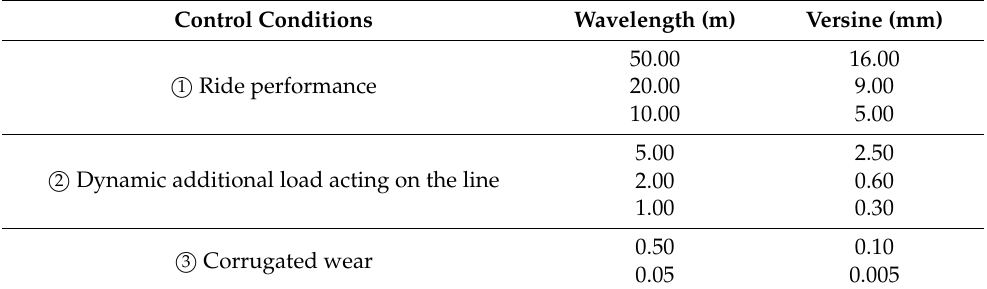
Table 2. Management values for track geometric irregularities in the United Kingdom.